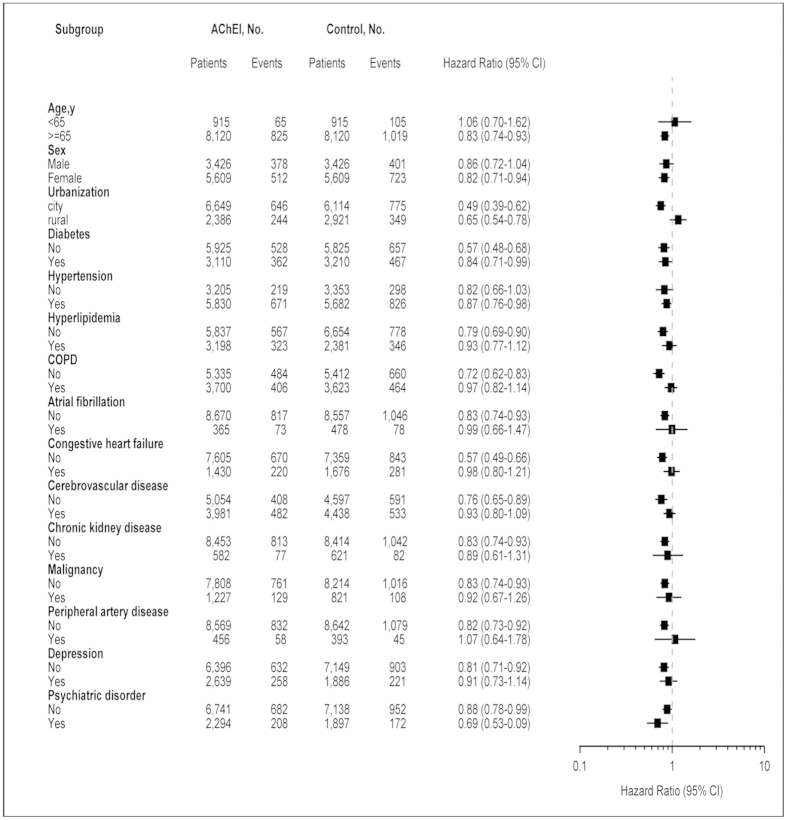
Stratified analysis for acute coronary syndrome (ACS).The risk of ACS in dementia patients with and without acetylcholinesterase inhibitors use (presented as hazard ratios and 95% confidence intervals) is shown, stratified by the baseline characteristics.